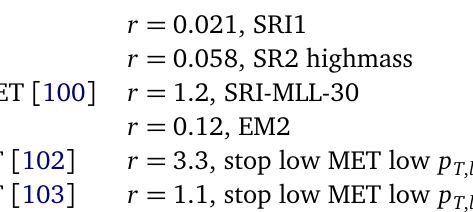
Table 7: Summary of constraints on benchmark point [ 5 ] from the most sensitive 13 TeV searches implemented in C HECK MATE at the LHC. The EM2 region is the − body same as the one shown in Table 6. SR 3 -SF is originally designed for stops with W ∆ m ( χ ) ∼ m and hence imposes a b -quark veto and cuts on a “super-Razor” (cid:101) t , W variable M R , that reaches an endpoint near the stop-neutralino mass splitting. 3LI ∆ simply imposes a moderate missing E cut and a tight requirement on the p of the T T third lepton. Finally, SR A25 imposes a harder / E cut as well as a transverse mass T cut, and tags Z bosons.